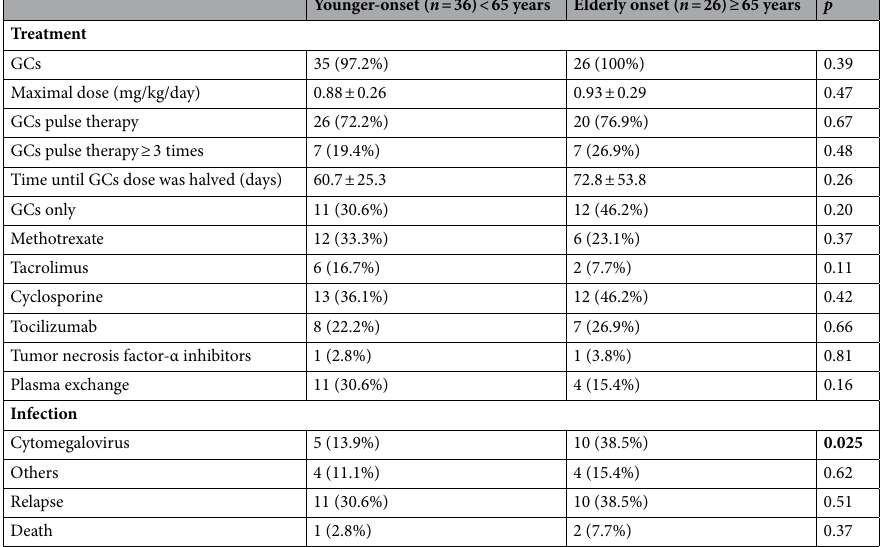
Table 2. Treatment and outcomes of patients with adult-onset Still’s disease by age group. Data are presented as numbers (%) or mean ± standard deviation. p < 0.05, are represented in bold. GC glucocorticoid.